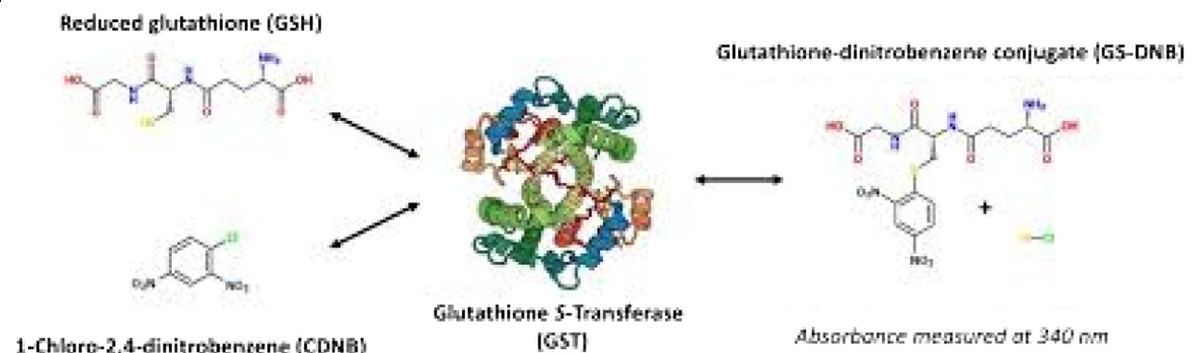
Fig. 1 GST catalyzes the conjugation of GSH to CDNB through the thiol group of the glutathione and making CDNB-GSH